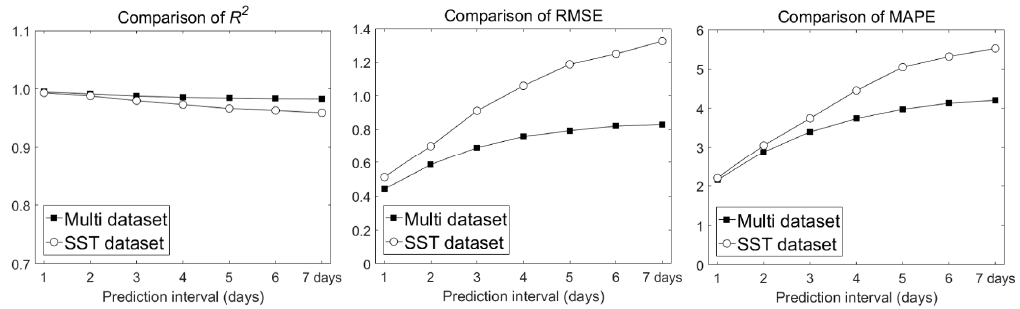
Figure 11. Comparison of coefficient of determination ( R 2 ), root mean square error ( RMSE ), and mean absolute percentage error ( MAPE) values between LSTM results produced using the SST and multi datasets as input, for different prediction intervals